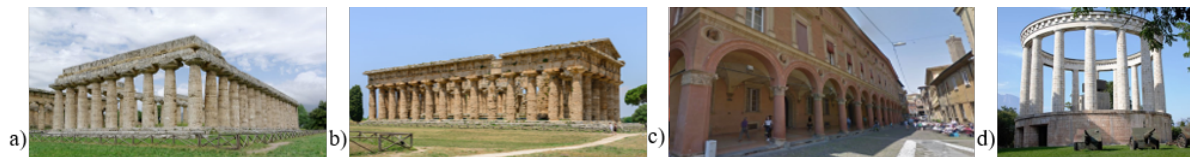
Figure 3. The case studies of the work: Basilica in Paestum, Italy (a), Temple of Neptune in Paestum, Italy (b), Porticos in Bologna, Italy (c), Mausoleum of Cesare Battisti in Trento, Italy (d).